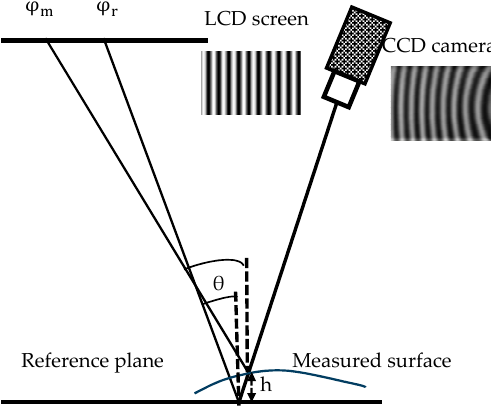
Figure 2. Principle of classical PMD to measure specular objects.